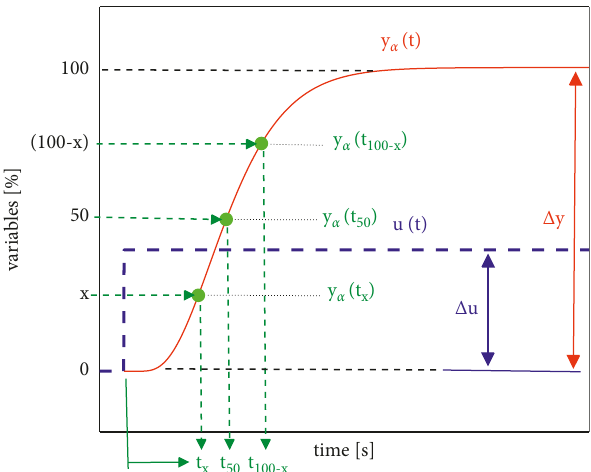
Figure 4: Step input signal and symmetrical representative points on the process reaction curve. Table 1: Numeric values of normalized times τ different values of α .